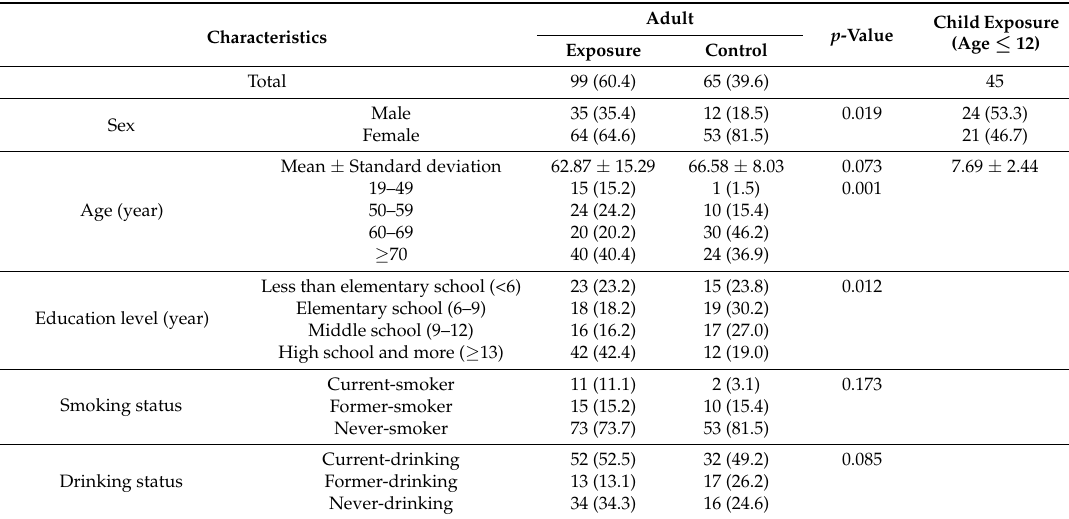
Table 1. Participant